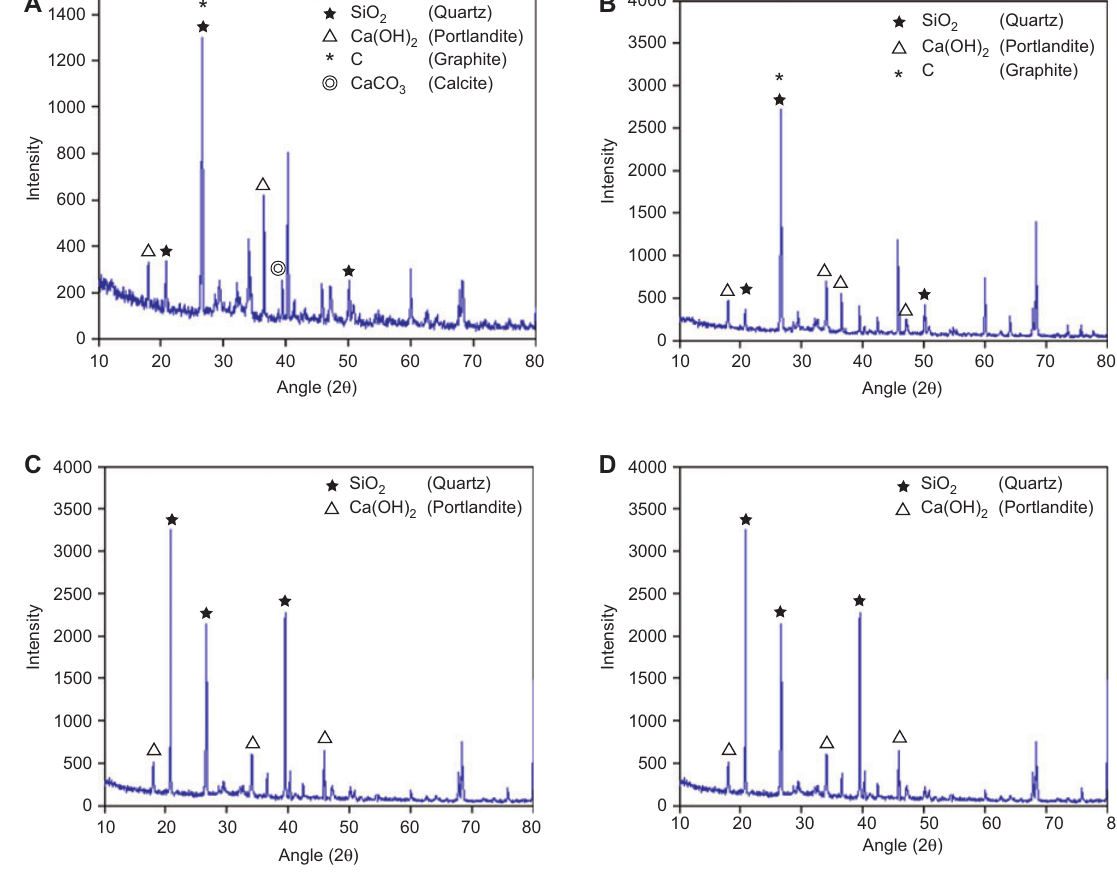
Figure 13 Typical XRD patterns of cement mortar (A) without montmorillonite, (B) with 5 % montmorillonite, (C) with 10 % montmoril- lonite, (D) with 15 %